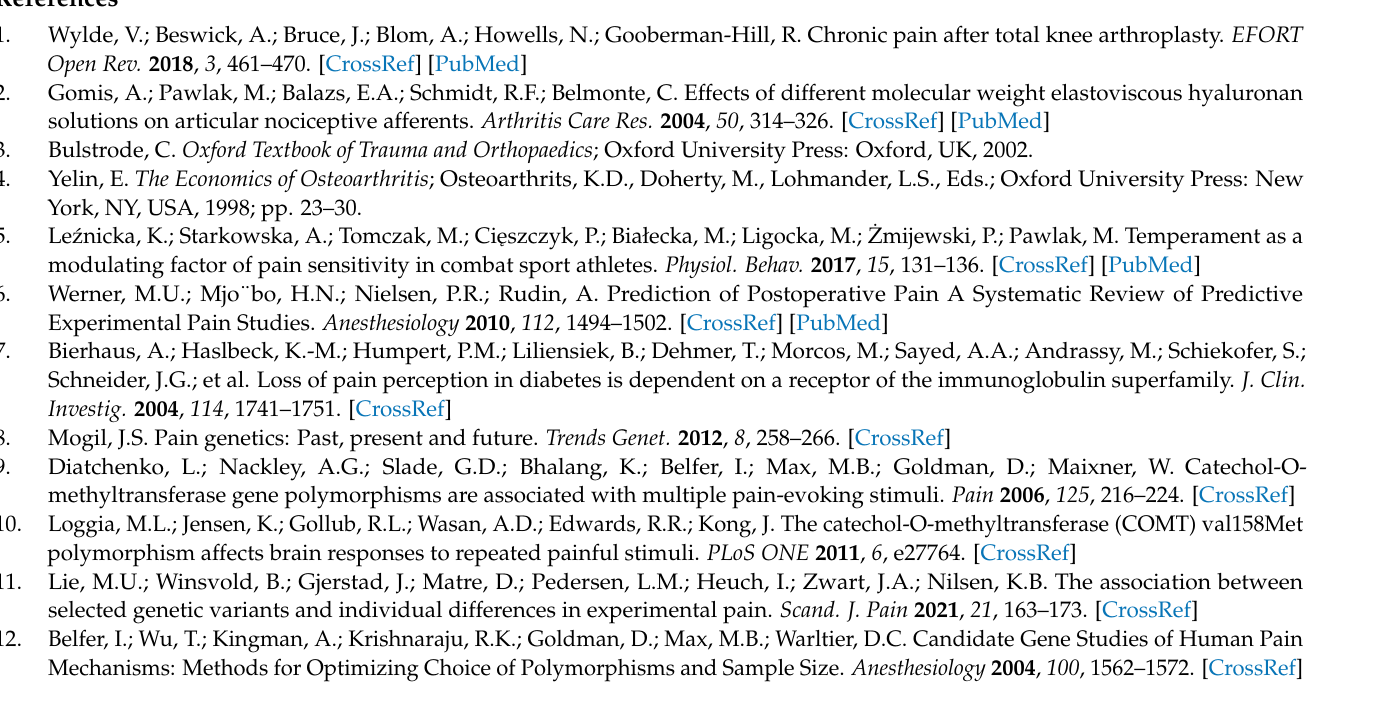
threshold. Table S3: Association of the COMT rs4818 with pain tolerance and pain threshold. Table S4: Association of the COMT rs6269 with pain tolerance and pain threshold. Table S5: Association of the OPRM1 rs1799971 with pain tolerance and pain